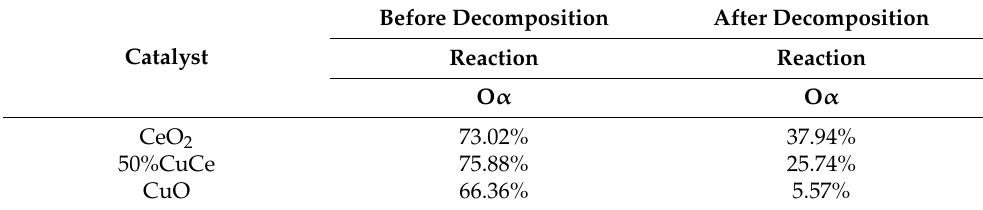
Figure 12. XPS spectra of the catalysts after the protection test: ( a ) CeO 2 , ( b ) 50%Cu/Ce, and ( c ) CuO. Table 6. O α contents before and after the catalytic decomposition of DMMP.